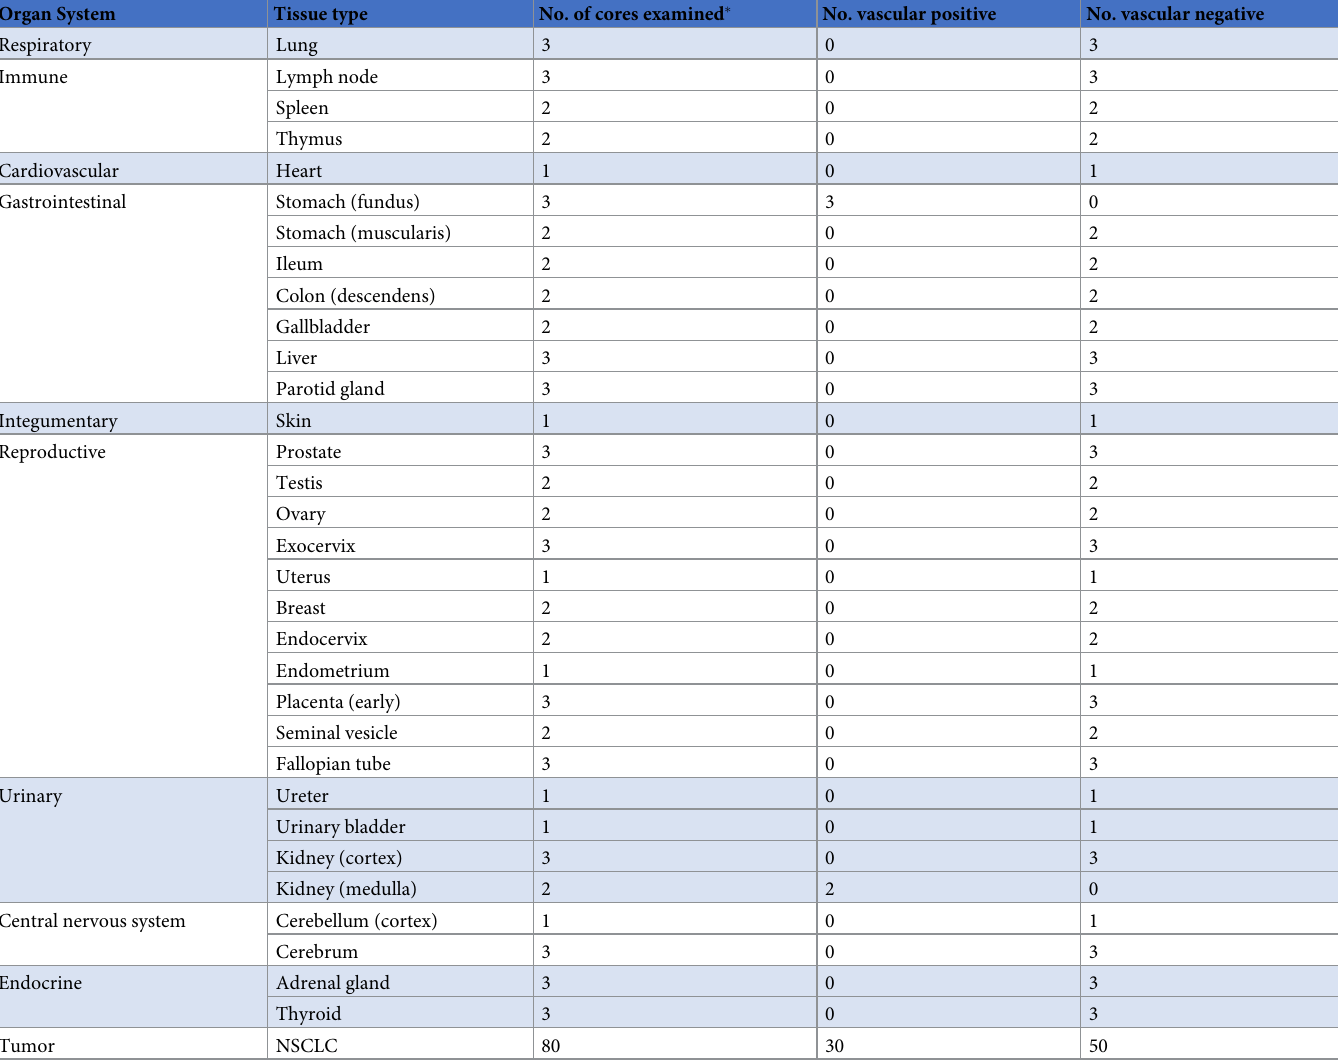
Table 1. Vascular anxA1 staining in TMAs of NSCLC and normal tissues. Vascular anxA1 staining was positive in 30/80 NSCLC TMA samples, with 54/80 samples demonstrating neoplastic staining. Vascular staining in normal tissues was negative with exceptions of kidney medulla (2/2 positive vascular staining) fundus (3/3 positive vascular